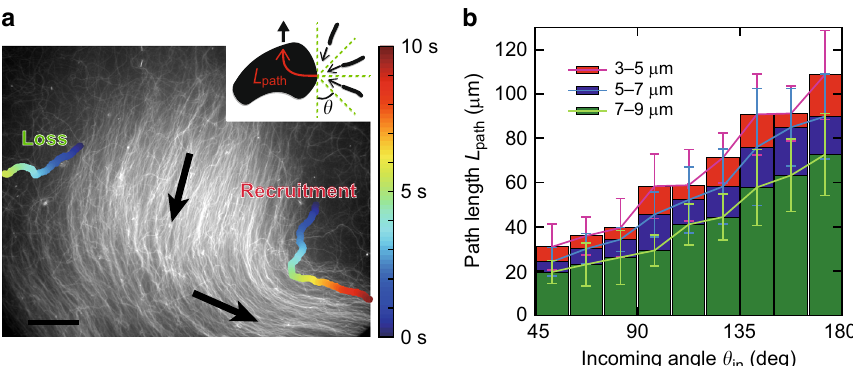
Fig. 4 Recruitment capacity of clusters at steady state. a Example of recruitment and loss of fi laments into and from a cluster. Image shows an overlap of a cluster for 10 s. The direction of cluster motion is depicted by black arrows . Scale bar is 30 μ m. Inset: Schematic of single fi laments entering a polar ordered cluster. The strength of fi lament recruitment is characterized by the decrease in L path . The incoming angle of a single fi lament with respect to the direction of motion of the cluster is θ . Here, θ = 180° corresponds to a single fi lament that enters the cluster by colliding head on. b Path length L path required for a single fi lament to align to the direction of cluster motion according to its incoming angle θ . Long fi laments coming into a cluster at an acute angle are persuaded the most. Data taken for events that are persuaded into the general direction of the cluster motion. Error bars: s.d. within each bin. Total